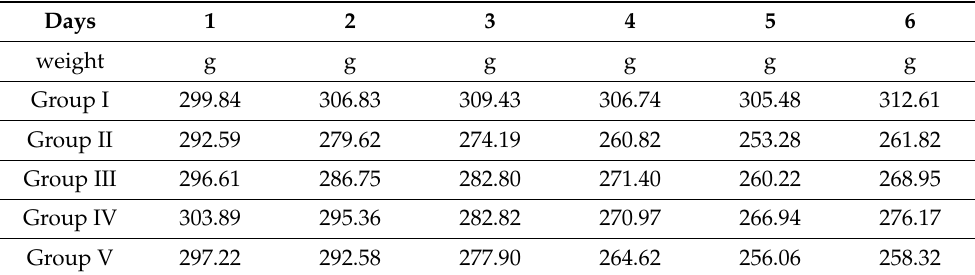
Table 3. Evolution of the weight of the animals included in the